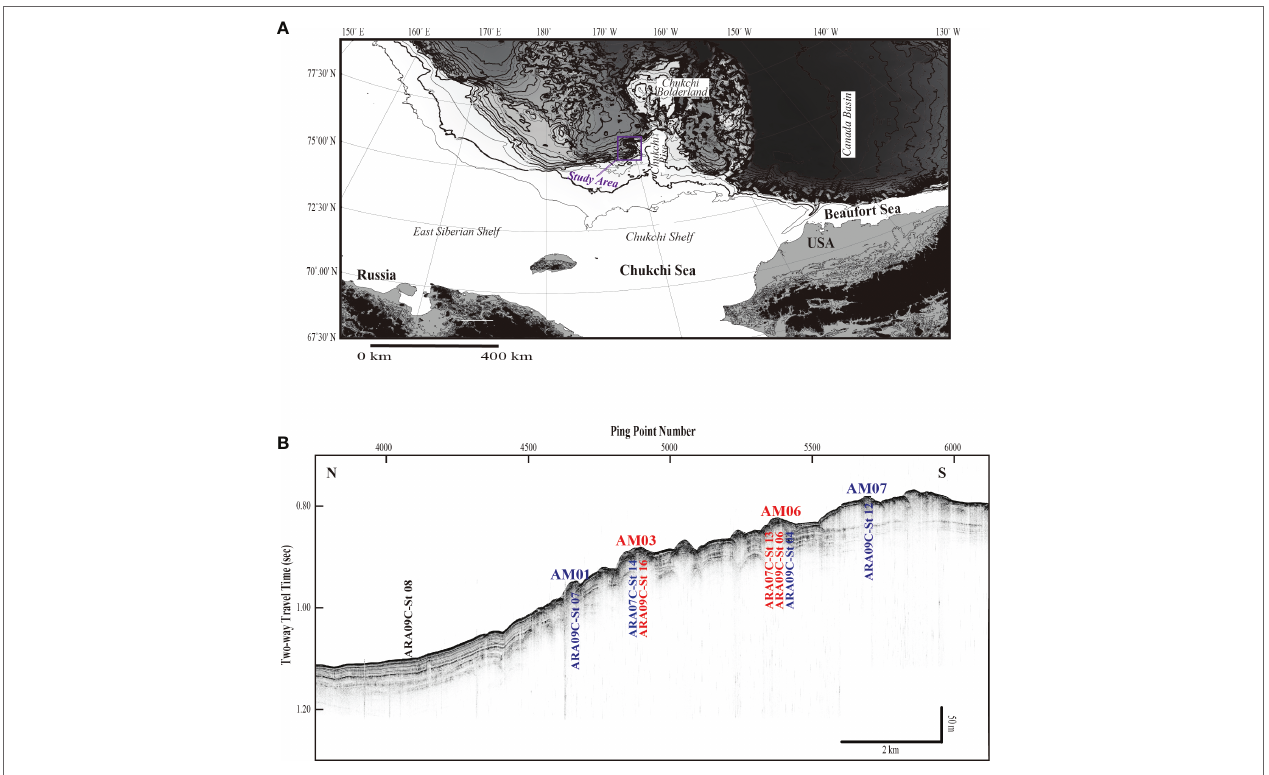
FIGURE 1 | (A) Major physiographic features and locations of the study area during the ARA07C and ARA09C Expeditions. (B) Sub-bottom profile (SBP) images of the ARAON Mounds (AMs) surveyed during the ARA09C Expedition. Black color site: reference site without GHs and MDACs, blue color sites: observation of MDACs, and red color sites: observation of GHs and